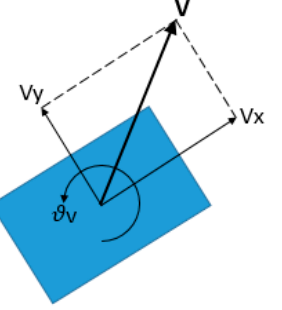
Figure 5. Different speeds involved in the movement of the autonomous vehicle.